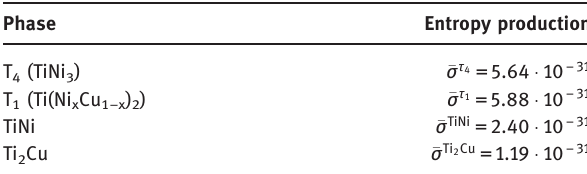
Table 3: The entropy production in Ti-NiCu system, sample 3. Phase Entropy production